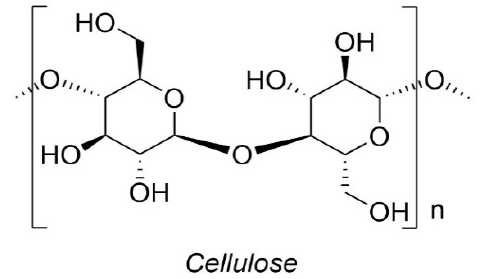
Figure 8. Schematic diagram of cellulose structure [81].